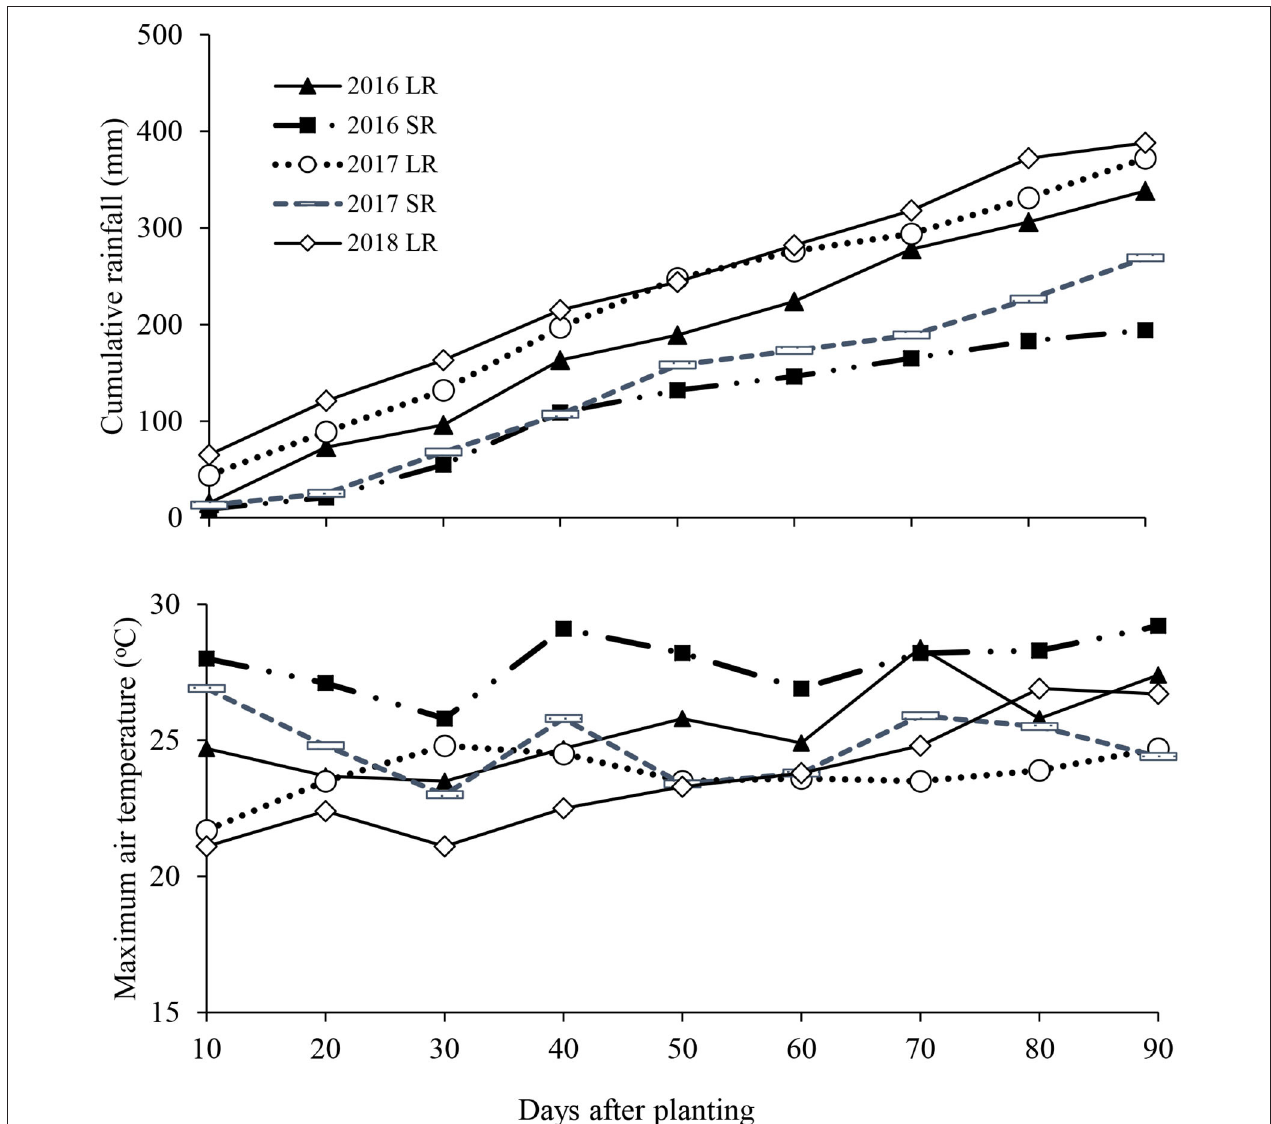
FIGURE 3 | Rainfall and temperature for the period between potato planting and harvesting. LR and SR denote long and short rains, respectively.